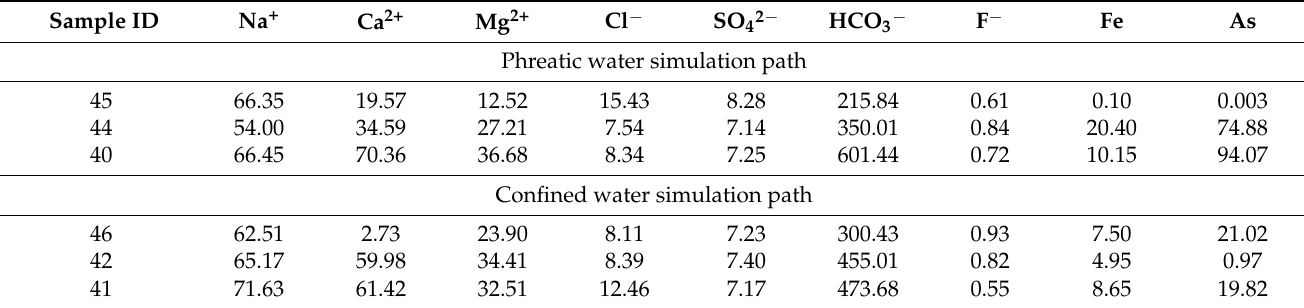
Table 5. Test results of major hydrochemical components in simulated paths of phreatic water and confined water. Sample